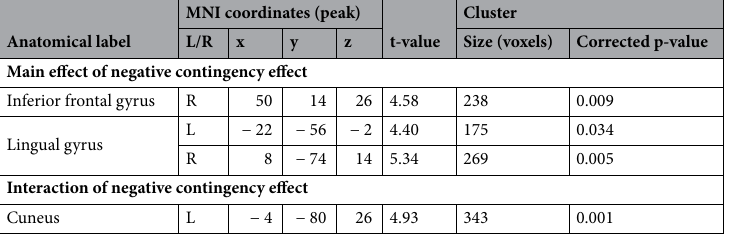
activation in voxel-wise analysis of the contact phase. Two-way ANOVA showed no significant main effect of contingency or interaction. Subsequent voxel-wise analysis showed no significant main effect of contingency or interaction on activation.